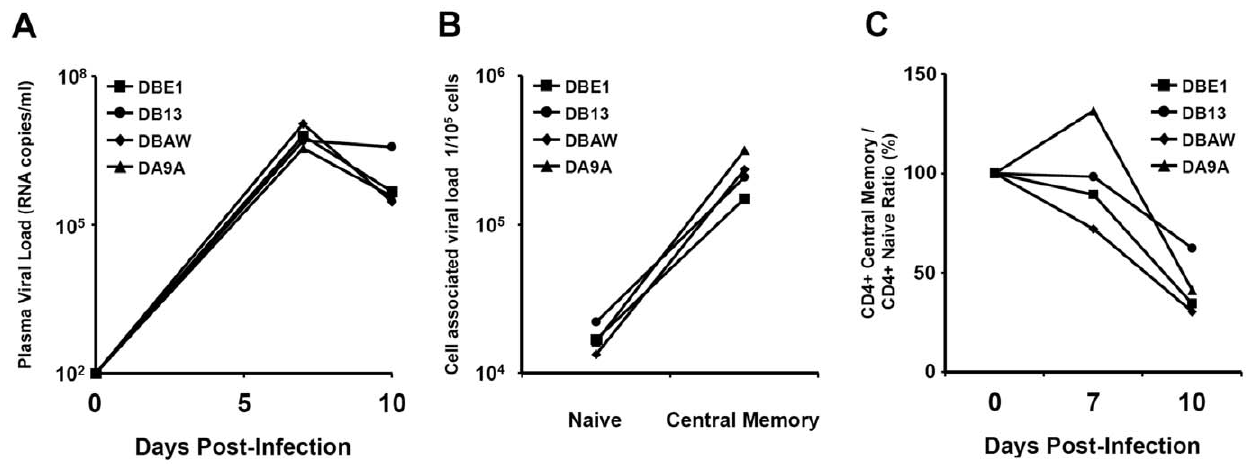
Figure 1. The peak of infection occurs at day 7 post infection. The plasma viral load assessed by a quantitative PCR measurement of viral RNA copies in sampled peripheral blood (A). The major viral production is attributed to CD4 + central memory cells, which constitutes the main target for the CCR5 tropic SIV mac239. At day 10 post infection the cell associated viral load is 13 fold higher in the central memory cells compared to the naive CD4 + cells, as assessed by quantitative PCR for integrated gag DNA (B). A preferential selective loss of central memory cells occurs over the course of the infection. Over half of the central memory cells are lost at day 10 post infection, illustrated here as the percent change in the ratio of central memory cells over naive CD4 + T cells; assessed by flowcytometry (C).